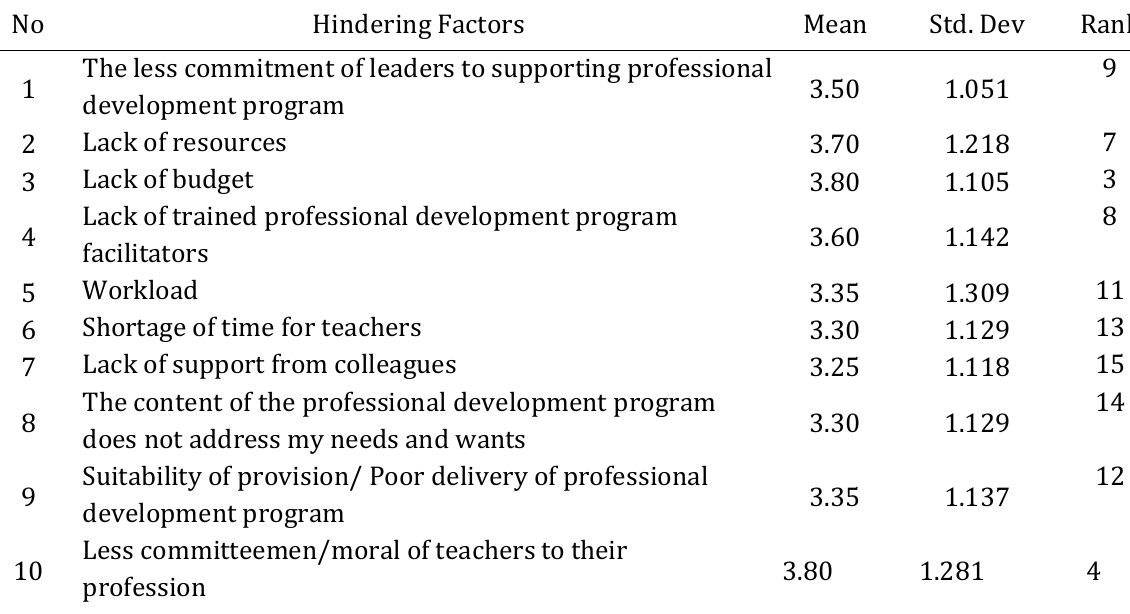
Table 7. Challenges EFL Teachers Face in Professional Development